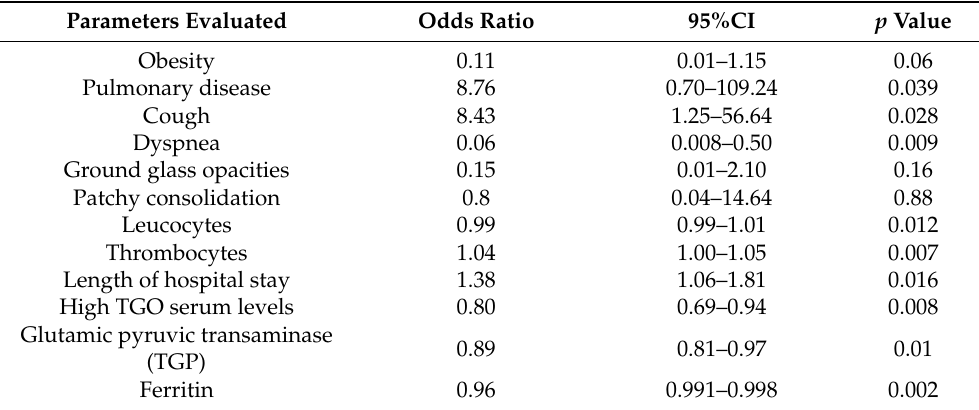
Table 5. A multivariate analysis of the parameters associated with maternal admission to the intensive care